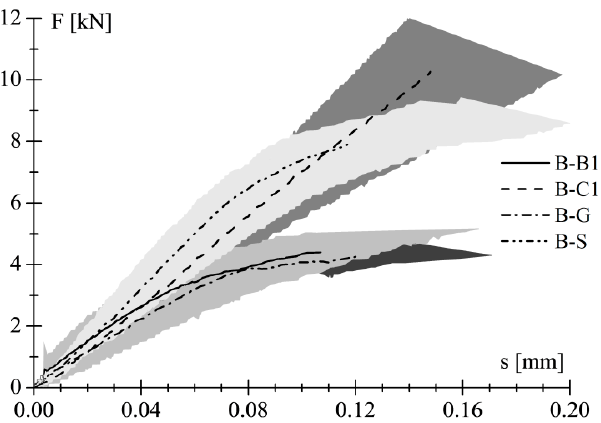
Figure 4. Average load–slip curves of shear bond tests on clay unit.